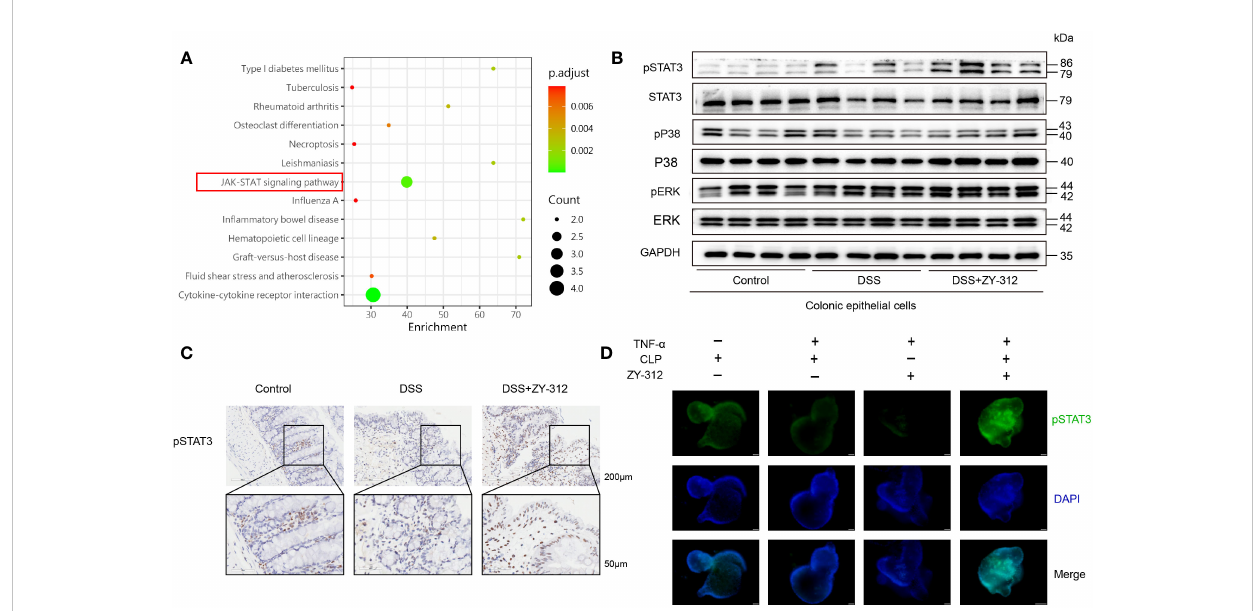
FIGURE 2 B fragilis motivated STAT3 phosphorylation in colonic mucosa. (A) KEGG analysis (DSS+ZY-312 group versus DSS group) of gene functions from colon tissue in DSS-induced colitis, linking B. fragilis with higher relation with the JAK-STAT signaling pathway in colitis (marked by a red box). (B) Western Blot analysis of pSTAT3/STAT3, pP38/P38, and pERK/ERK signaling pathway in colonic mucosa. (C) Immunohistochemistry analysis of pSTAT3 in colonic mucosa. Scale bars, 200 m m (upper), 50 m m (below). (D) Immuno fl uorescence analysis of pSTAT3 in colonic organoids from co- culture model, The co-culture model was added with (+) or without (-) B. fragilis strain ZY-312 (10 4 CFU/well) after TNF- a (60ng/ml) induced in fl ammation for 24 hours in vitro . (Scale bars,50 m